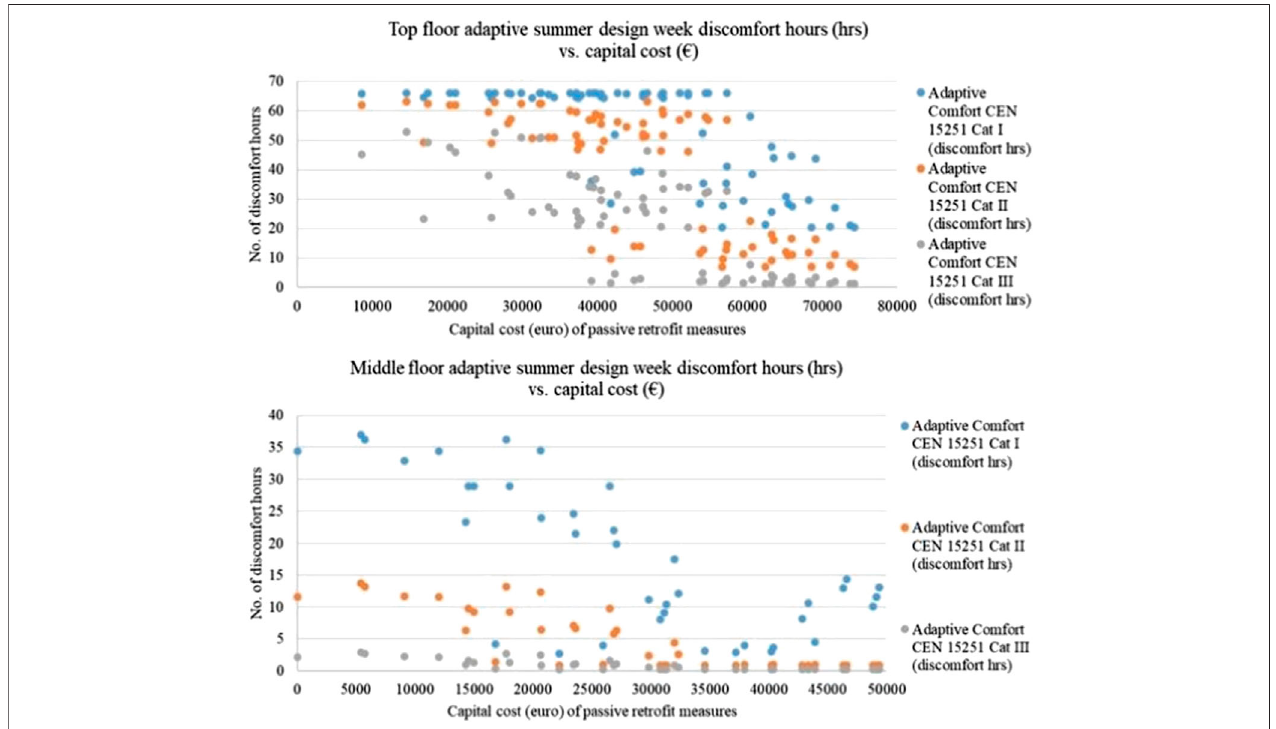
FIGURE 4 | Top fl oor (top image) and middle fl oor (bottom image) summer design week (adaptive comfort) discomfort hours vs. capital cost of passive retro fi t